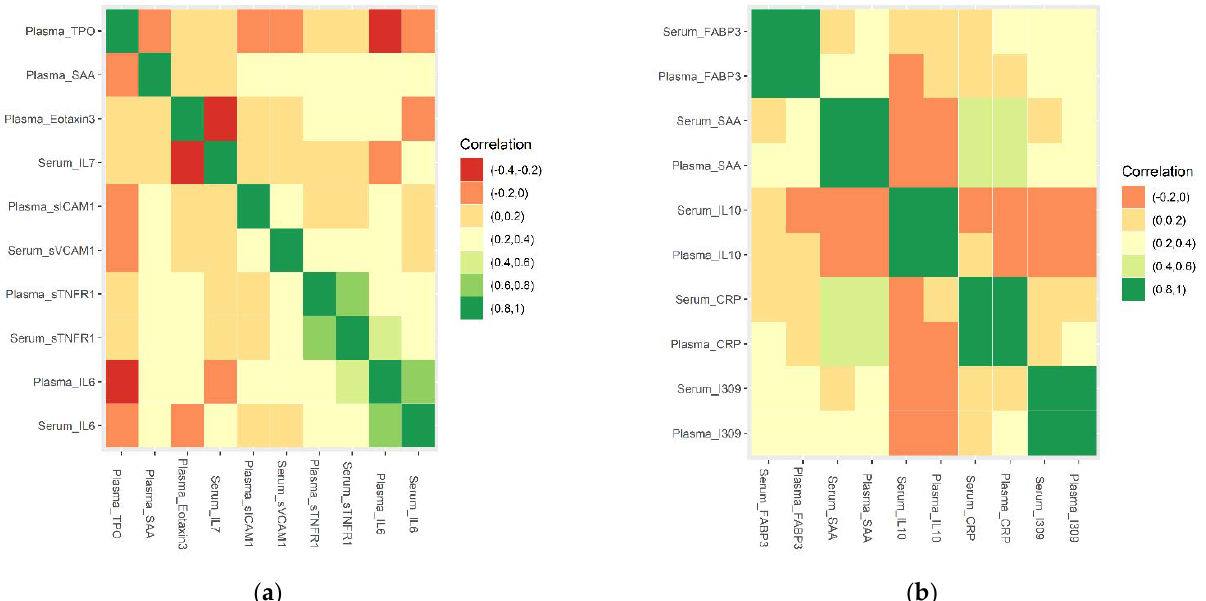
Figure 2. Correlation of selected 10 serum and 10 plasma biomarker combinations ( a ) selected 10 serum and plasma biomarkers ( b ) unselected 5 pairs of serum and plasma biomarkers that were highly correlated. Table 2. Protein changes in the selected serum and plasma biomarker panel.